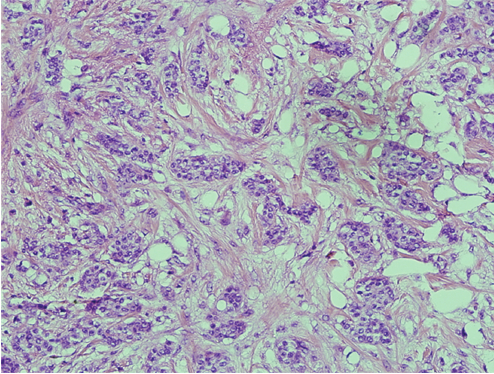
Figure 3: Left breast infiltrating ductal